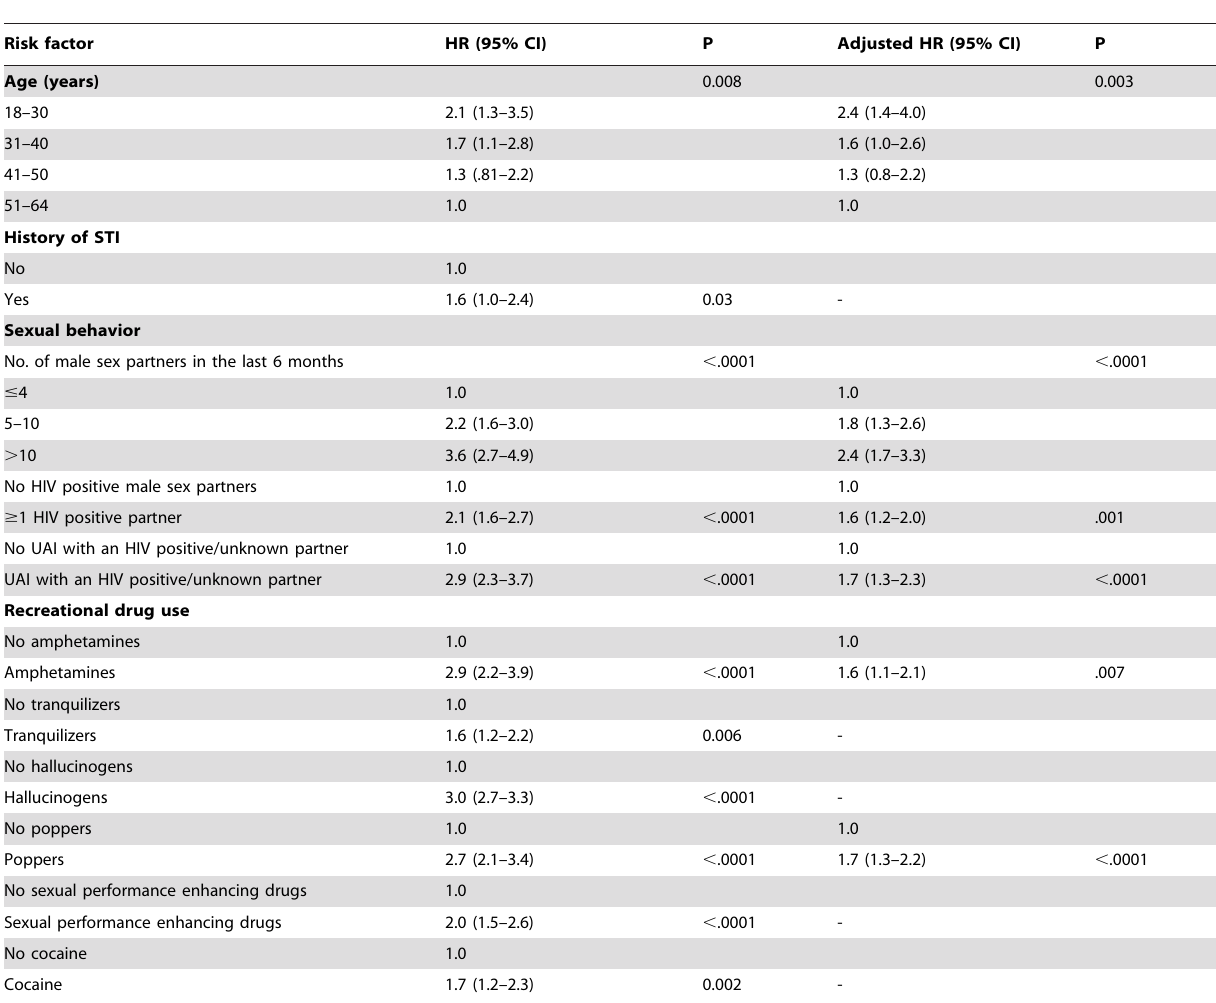
Table 2. Risk factors for HIV infection among MSM in univariate and multivariate analyses,